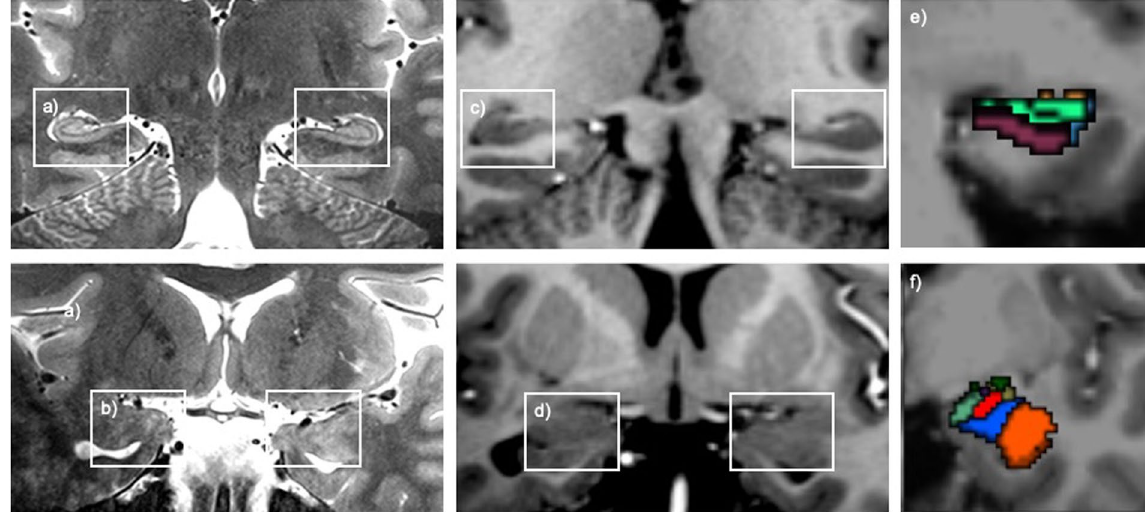
Figure 1. ( a ) T2-weighted images in the coronal orientation showing visibility of the hippocampus and ( b ) the amygdala at a resolution of 0.21 × 0.21 mm. ( c ) T1-weighted images in the coronal orientation showing visibility of the hippocampus and ( d ) the amygdala at an isotropic resolution of 0.7 mm. ( e ) Example coronal slice of the hippocampal subfield segmentation and ( f ) the amygdala nuclei